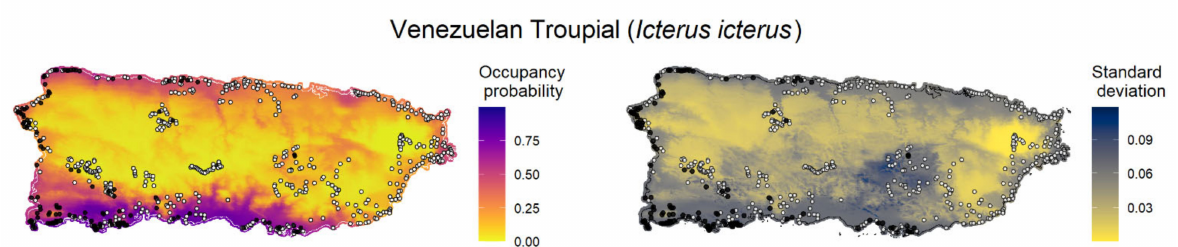
Figure 3. Maps of model-forecasted (mean expected occupancy probability) and the model prediction uncertainty (standard deviation) for Venezuelan troupial ( Icterus icterus ) across the main island of Puerto Rico (top-ranked model used in prediction was ψ (elevation + precip + spatial1000); ρ (elevation + date + date2)). The black circles represent the sampling sites where the species was detected and the white circles represent sampling sites without